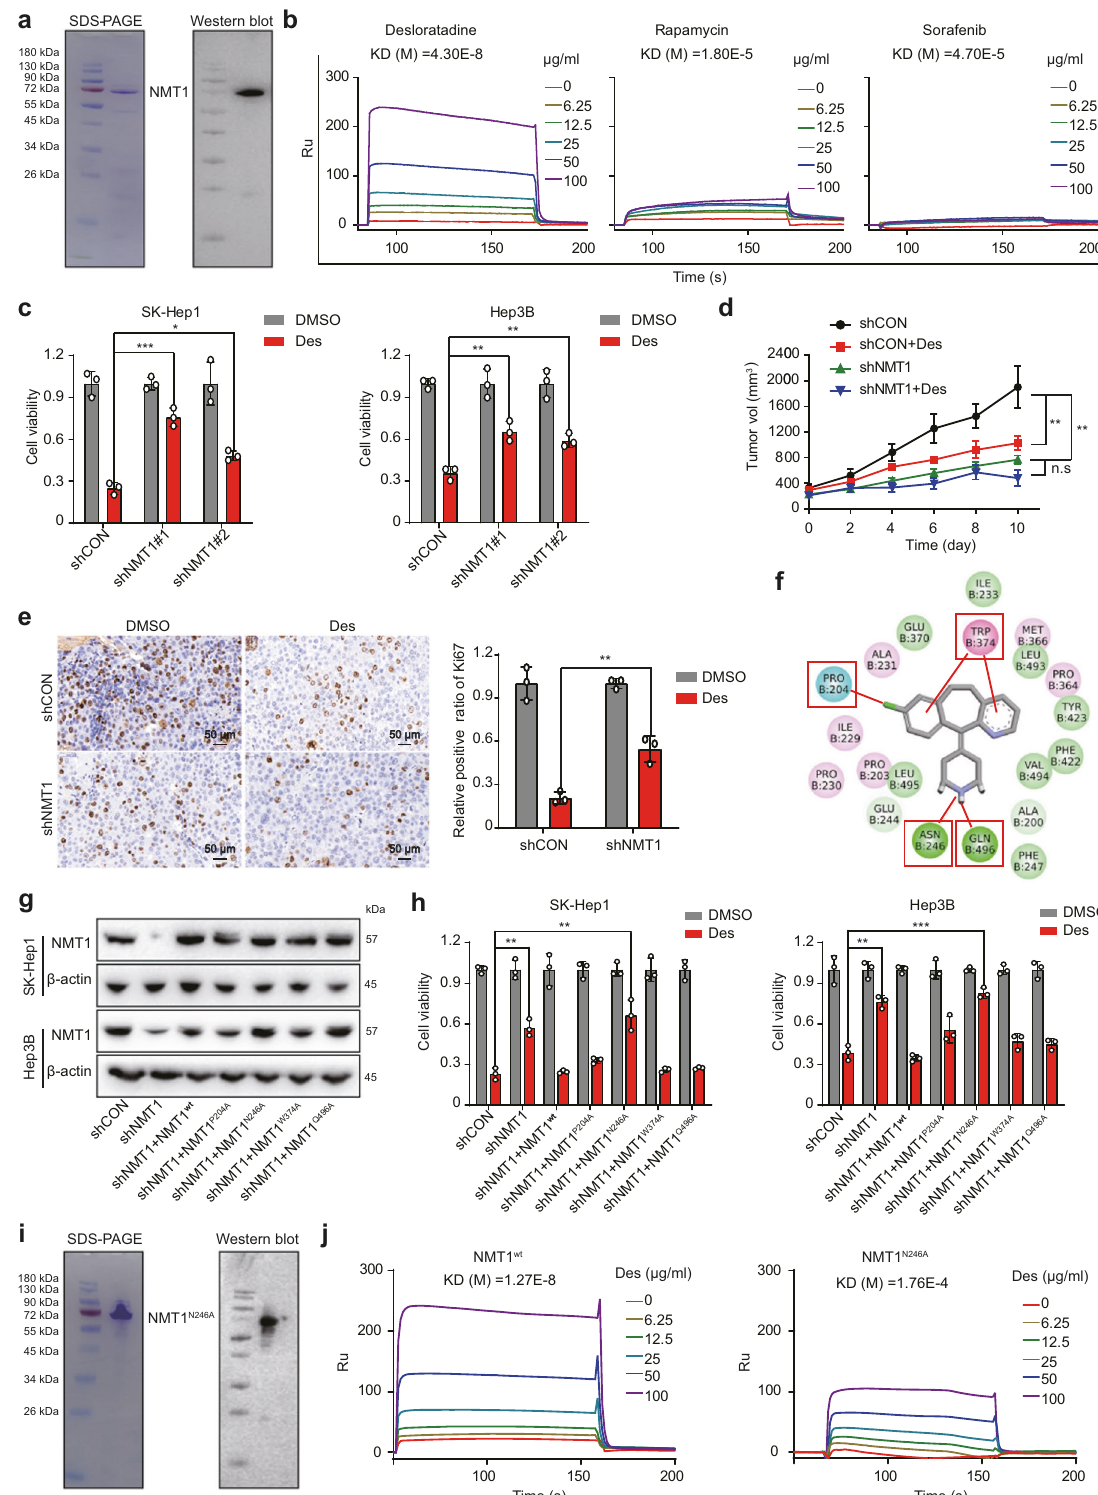
Furthermore, inhibition of the VILIP3/NF κ B/Bcl-2 regulatory axis was also observed in the desloratadine-treated Huh7 and HepG2 tumor xenografts (Supplementary Fig. 7). We also analyzed the correlation between NMT1 and 102 downstream genes of NF κ B signaling pathway based on the TCGA database. As shown in